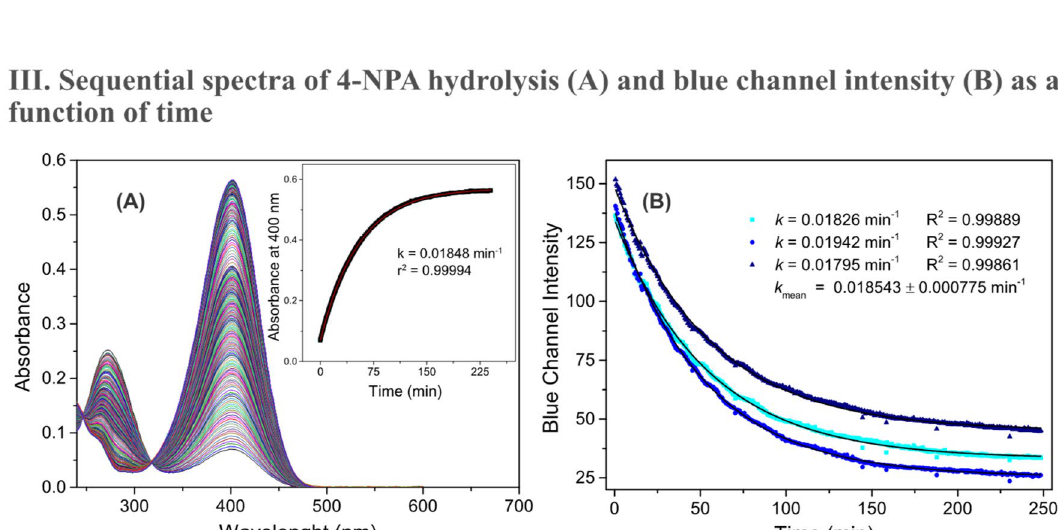
Figure 2. Base promoted hydrolysis of 4-NPA (I). Selection of digital images used in 4-NPA hydrolysis monitoring (II). Successive scan spectra for the hydrolysis of 4-nitrophenyl acetate and absorbance profile at 400 nm as a function of time (III- A ); blue intensity profile as a function of reaction time (III- B